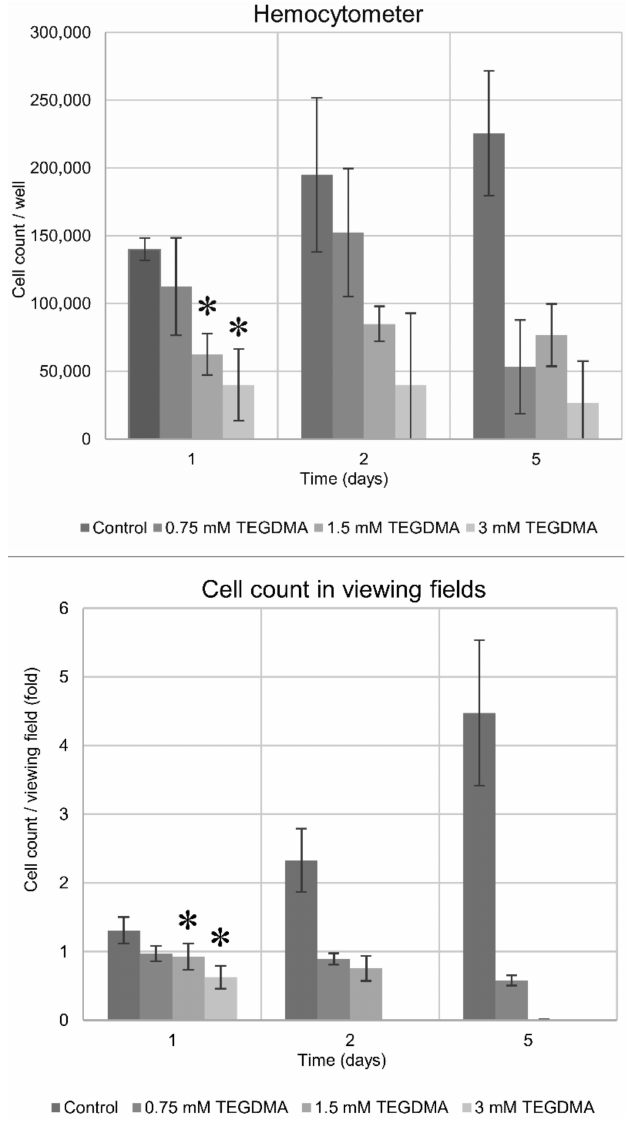
Figure 3. Number of viable pulp cells at various time-points of the 5-day exposure to 0.75, 1.5, and 3 mM TEGDMA, as measured by a hemocytometer and counted in marked fields of view. The hemocytometer graph presents the absolute number of viable cells, while the marked fields of view graph plots the decrease in the number of viable cells as a ratio relative to the control cell number at the start of the experiment. * = significantly different from the untreated control of the first day (for the hemocytometer, P = 0.0018, P = 0.0002 at 1.5 mM and 3 mM TEGDMA concentrations, and P = 0.0293, P = 0.0004 at 1.5 mM and 3 mM TEGDMA concentrations for the viewing field data, respectively, sample number: n =